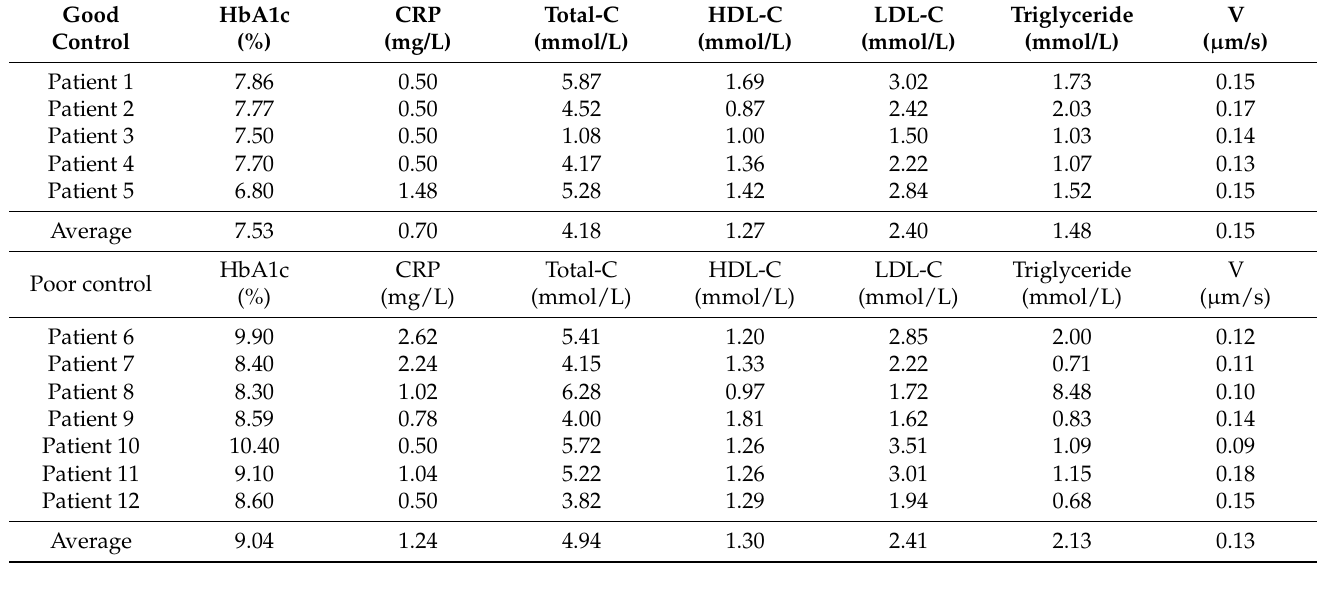
Table 1. The serum levels in the “well-control” and “poor-control” TD2M patients.